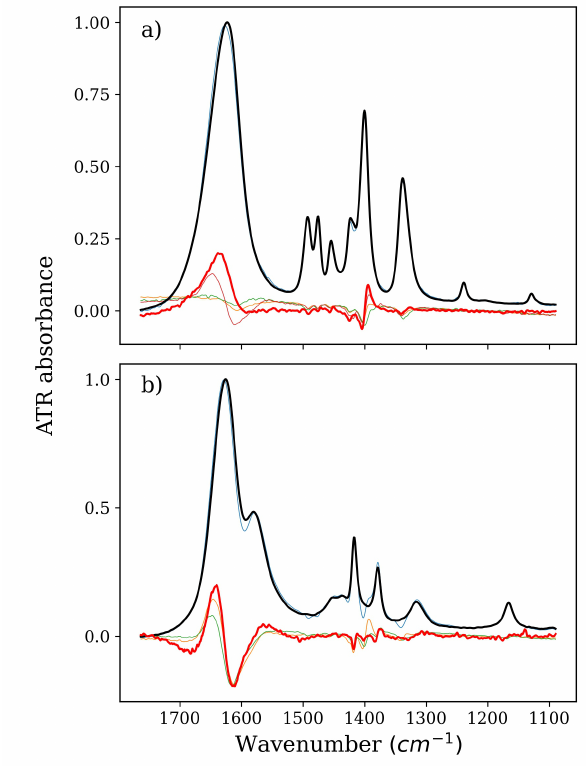
Figure 3. Spectra of pure BET or NMA solution (thick black lines), derivatives (thick red lines), and isolated spectra of factors from a series devoid of ( a ) water and NMA or ( b ) water and BET (all other thin lines). Part ( a ), therefore, denotes BET, and Part ( b ) denotes NMA, both corresponding to the green and magenta series in Figure 6b,